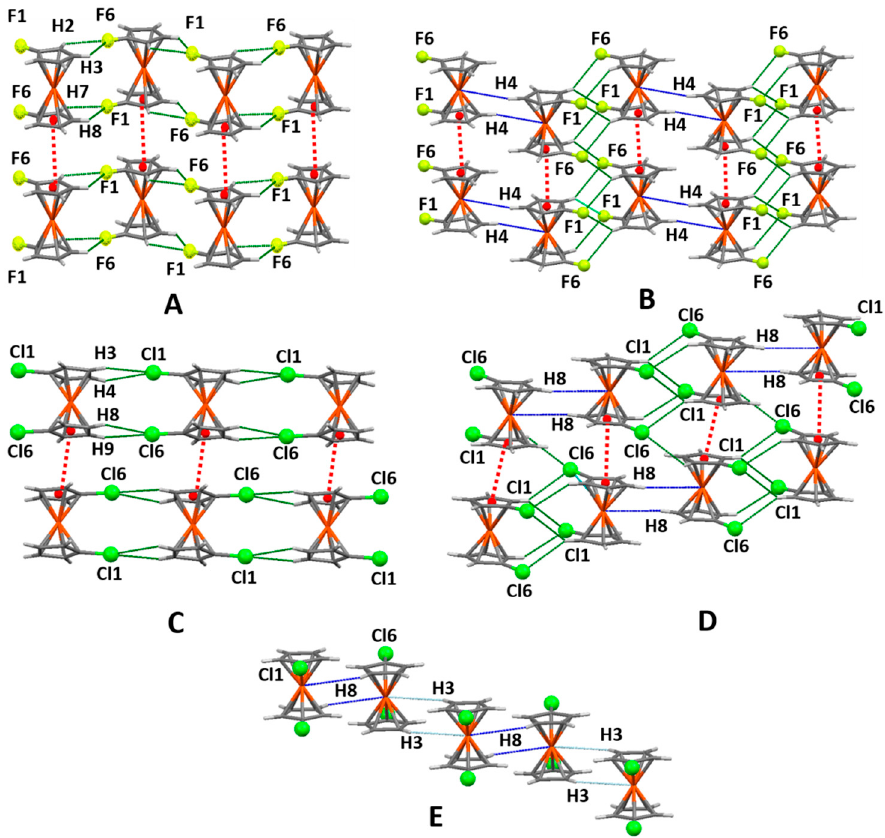
Figure 5. View of supramolecular arrangements of (CpF) 2 Fe (planes 0,1,6 ( A ), and 0,0,1 ( B )) and (CpCl) 2 Fe (planes 1,0,1 ( C ), 1,0,1 ( D ) and 1,0,0 ( E ).